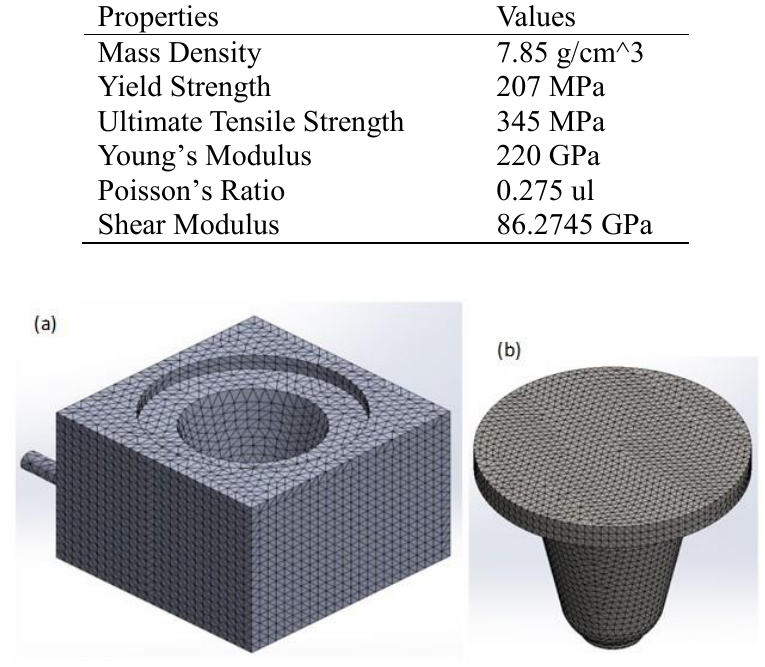
Fig. 7. Mesh of the mould (a) female mould, (b) male